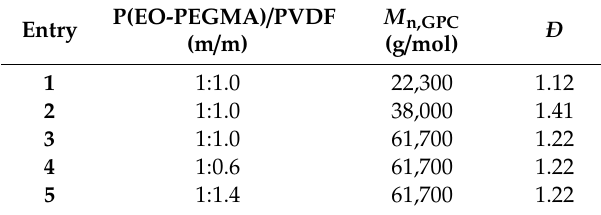
Table 3. Component of P(EO-PEGMA) / PVDF polymer